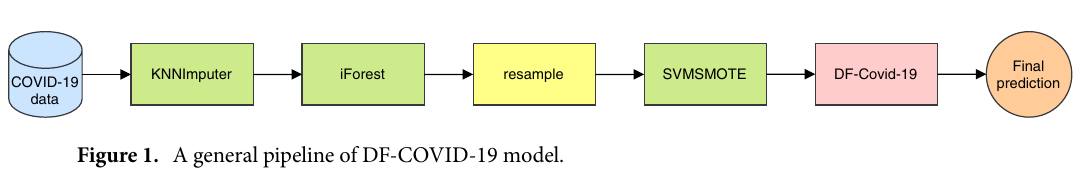
Fig. 1. The green rectangles represent data preparation steps. In this study, there are three steps to prepare data. The first step is handling missing values where KNNImputer is utilized from sklearn.impute Python library. For imputation, KNNImputer used the k-nearest neighbors algorithm. The number of nearest neighbors is deter- mined by n_neighbors parameter which was set to 11 in this work. The second step is removing outliers with isolation forest (iForest) 55 from sklearn.ensemble Python library 56 . Removing outliers improves the classification model performance because there are quantity and quality differences between outliers and normal records. The initial step iForest follows to remove outliers is creating an ensemble of isolation trees (iTrees). Then, detecting outliers is done by computing the average path lengths for each instance on the iTrees, outlier has a short average path length. The proposed model tunes two parameters of iForest: n_estimators and contamination. The number of estimators has been set to 150. The contamination parameter controls the outliers ratio in the dataset. The contamination parameter has been set to 2%. After that, from sklearn.utils Python library resample is employed to create small multiple subsets with replacement from the entire dataset. This resampling step enhances data variety and randomness. Thereafter, the whole dataset is randomly split into the training set (80%) and the test set (20%). The third step in data preparation is balancing the training data. This is an important step to avoid the bias of classifying toward the majority class. To achieve class balance, the dataset has been processed with SVMSMOTE 57 . The SVMSMOTE is an over-sampling technique using the SVM algorithm to generate new